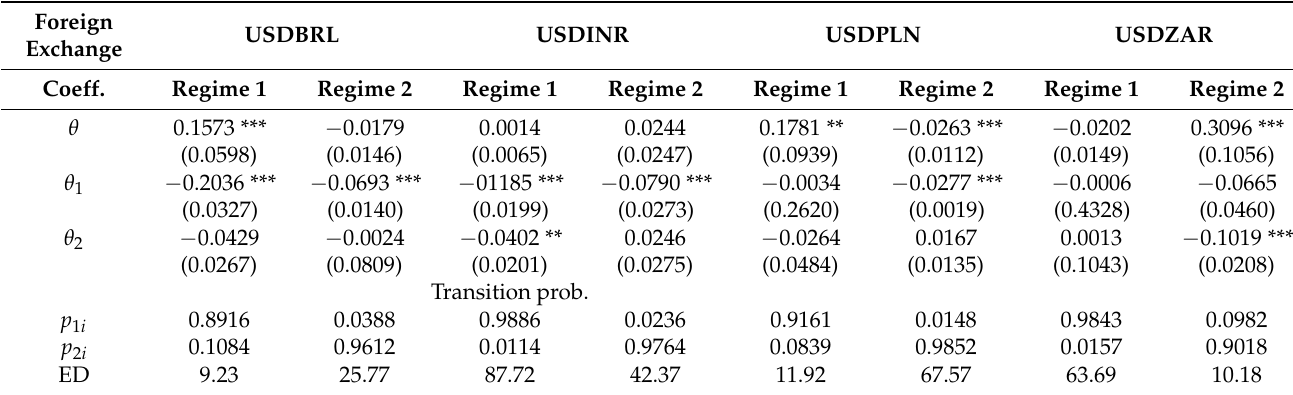
Table 3. Markov Switching (MS) estimates.